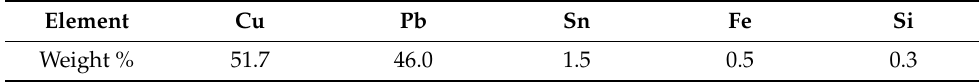
Figure 10. EDS spectrum for a representative sample area. Table 1. Chemical composition of the tested